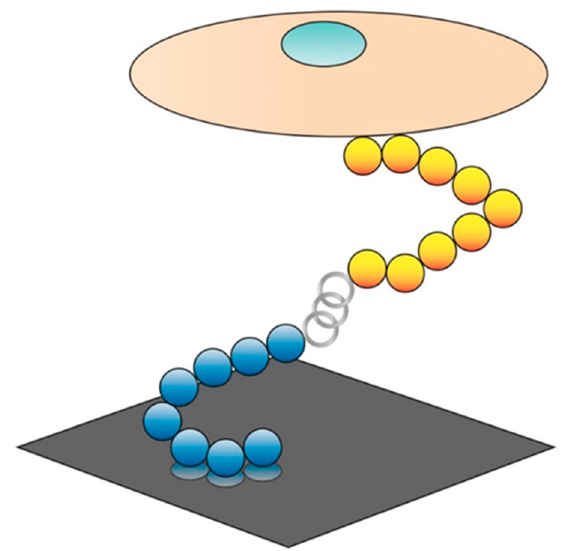
Figure 6. Dual-functioning peptide schematic with a targeting peptide ( blue ) attached to a substrate ( dark grey ) connected to a functional or specific cell targeting peptide ( yellow ) via spacer amino acids ( light grey ). Image modified from [44] and used with permission from Advanced Materials.